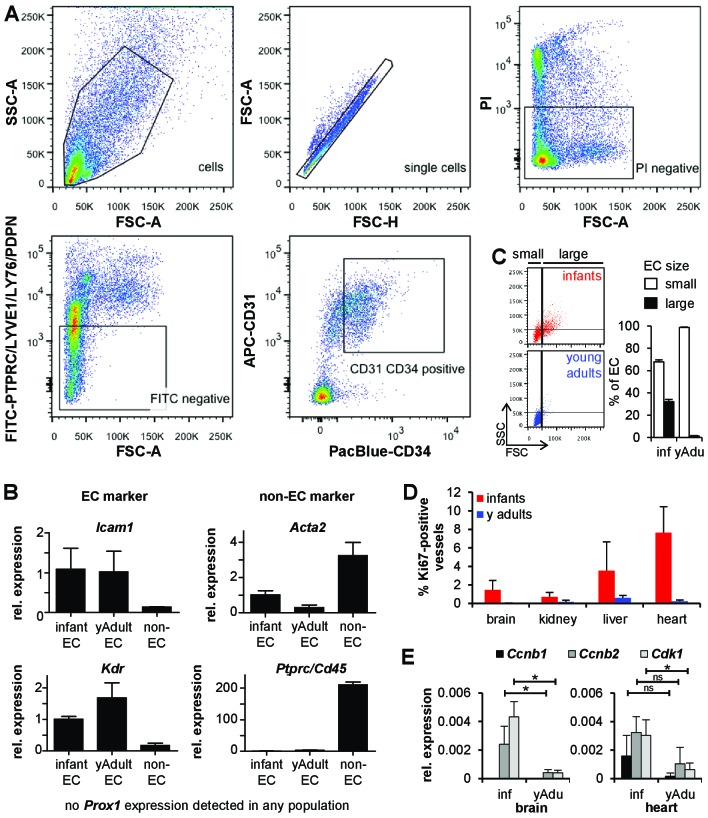
Characterization of endothelial cell populations.(A) Sorting strategy for lung EC isolation. PTPRC‐LYVE1‐LY76‐PDPN‐PI‐CD31+CD34+ cells were used for transcriptome and methylome analysis. Propidium iodide (PI) was used to discriminate between live (PI‐) and dead (PI+) cells. (B) Validation of the sorted EC populations by marker gene expression analysis using qPCR. n = 3; mean ± SD. (C) Size analysis of EC populations (CD31+CD34+) isolated from infant and young adult mice. (D) Analysis of EC proliferation from brain, kidney, liver and heart by Ki67 and Cd31 co-staining. n ≥ 5; mean ± SD. (E) Validation of the differential expression of cell cycle genes in infant and young adult brain and heart EC using qPCR. n ≥ 3; mean ± SD; *p<0.05; Mann-Whitney Test.